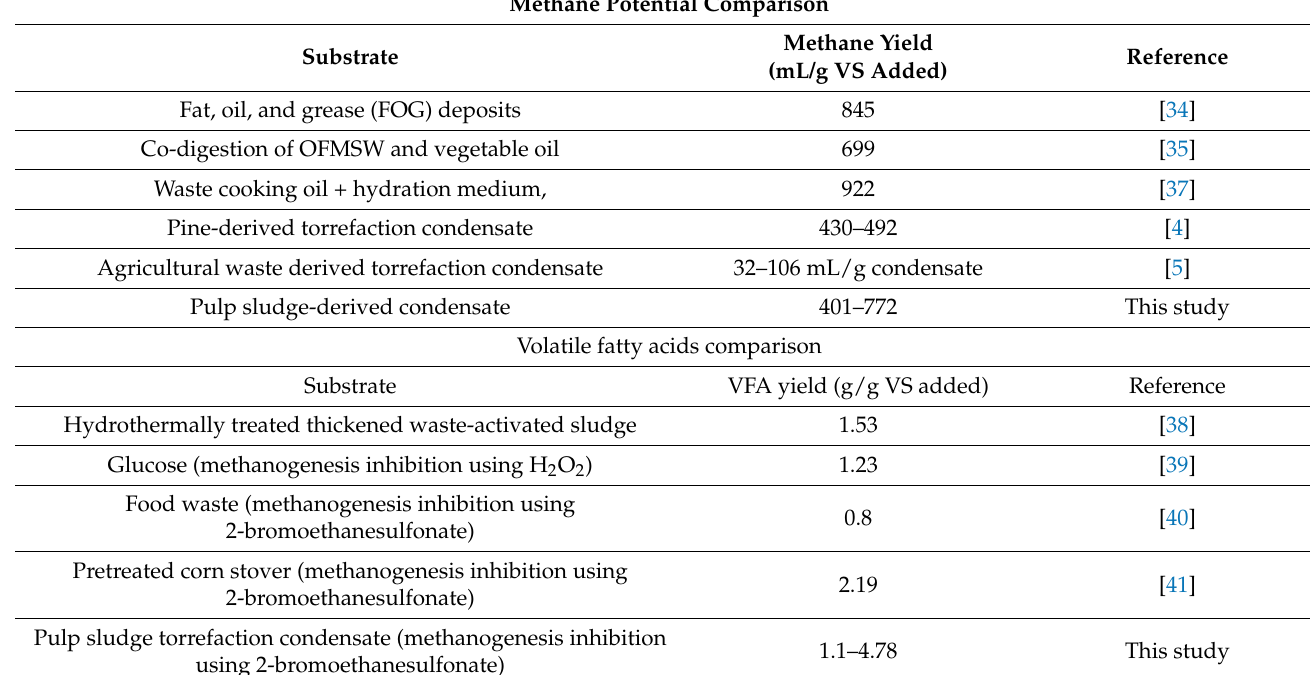
Table 2. Comparative data of methane and volatile fatty acid yields from different substrates and torrefaction